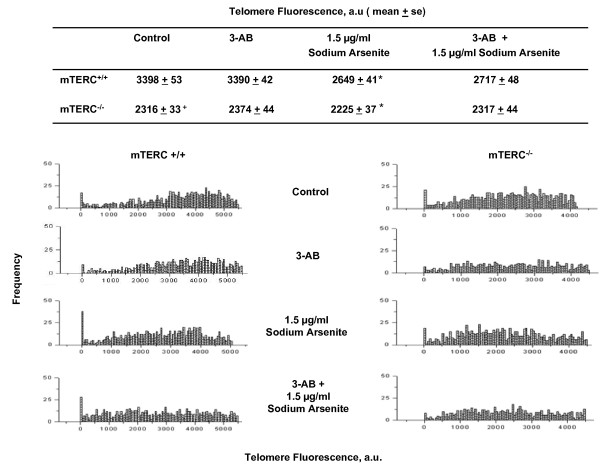
Telomere length measurements by Q-FISH in different cell types used. Frequency distributions of telomere fluorescence in mTERC+/+ and mTERC-/- MEFs from Q-FISH studies on metaphases prepared from surviving cells following treatment with PARP inhibitor and arsenite. Average telomere fluorescence intensity was significantly lower (+p < 0.05) in untreated mTERC-/- as compared to untreated mTERC+/+ cells. Arsenite treatment led to significant decrease (*p < 0.05) in average mean telomere florescence intensity in both mTERC+/+ cells and mTERC-/- cell as compared to respective untreated controls. Changes in distribution of frequency of cells with shorter telomere fluorescence intensity observed following treatment with 3-AB and arsenite in both mTERC+/+ and mTERC-/- cells.